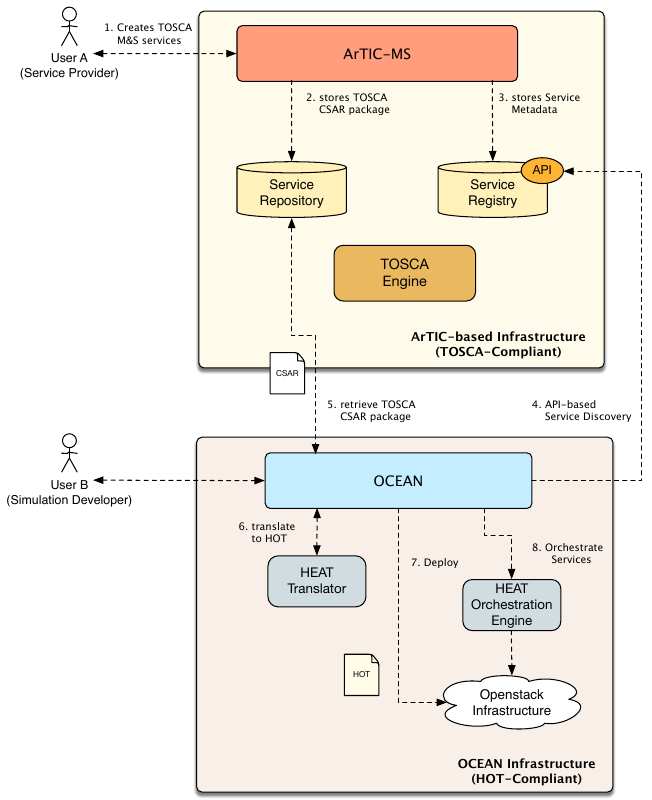
Figure 14. Federation of ArTIC-MS and